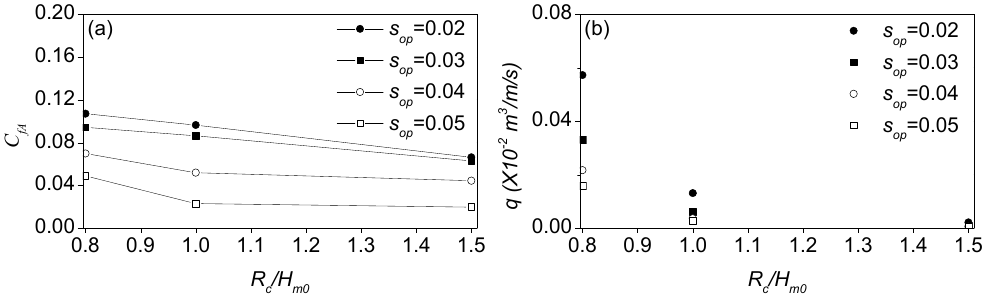
C ( a ), q ( b ) simulated by the SWASH model. Figure 4. Relationship between R c / H m 0 and C fA ( a ), q ( b ) simulated by the SWASH model. fA